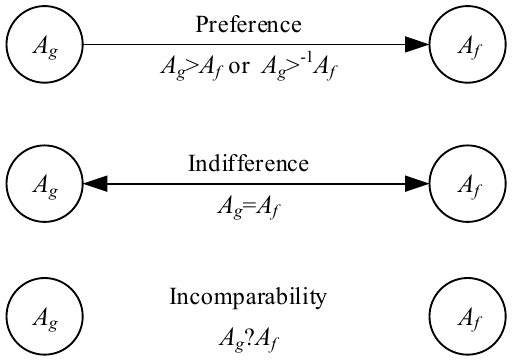
Figure 3. The graphical representation of the binary relations (>, =, ?) used in the decision graph.